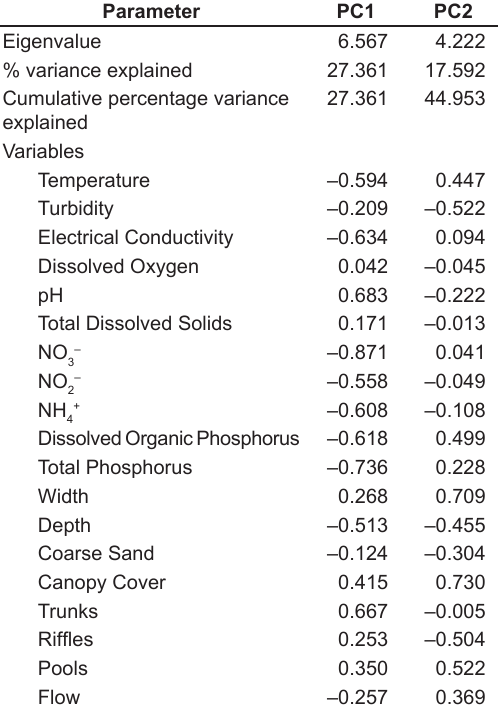
Table 2. Loadings of the abiotic variables on the first two principal components (PC) and the proportion of variance explained by each component.